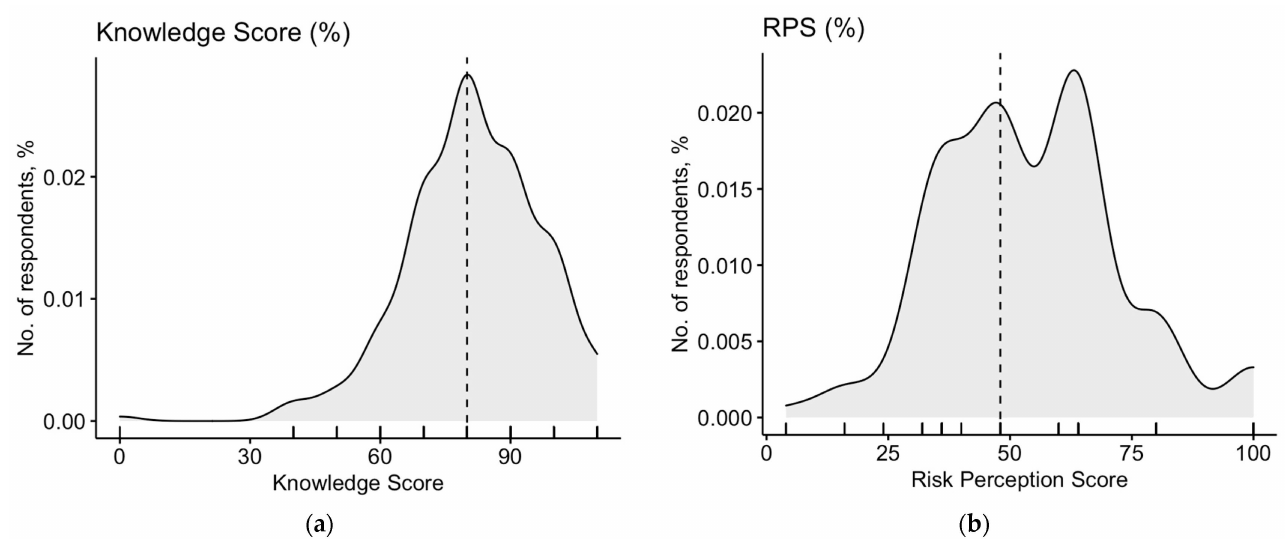
Figure 1. Density plots for: ( a ) General Knowledge Score (GKS) in 242 Italian occupational physicians participating into the survey; ( b ) Density plot Risk Perception Score (RPS). Cumulative scores were substantially skewed (D’Agostino–Pearson’s normality test p -value 0.038 and <0.001, respectively). Dotted line represents median value (72.7% and 48.0% for GKS and RPS, respectively).